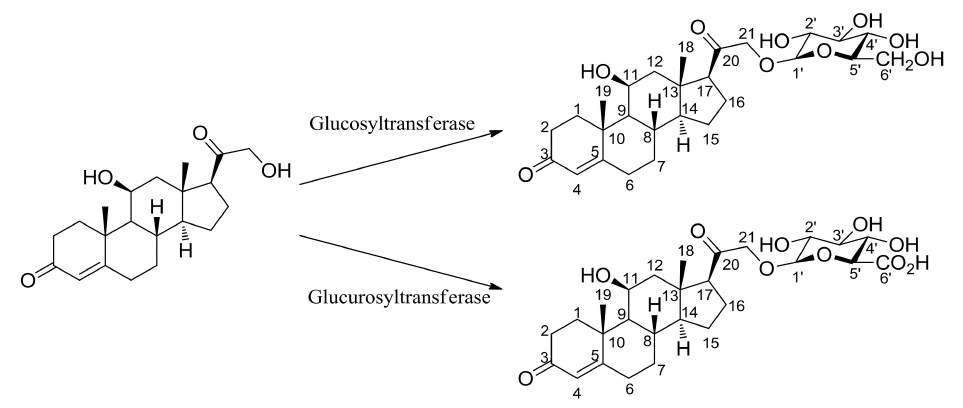
Figure 1. The glucosyltransferase and glucurosyltransferase [32] reaction scheme of corticosterone.